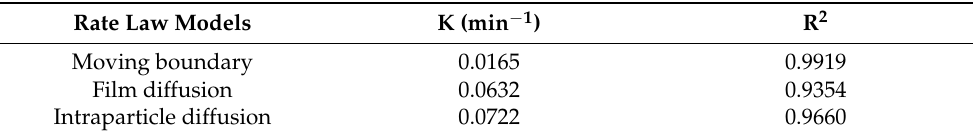
Table 4. Calculate rate constant and correlation coefficients for the rate law models.